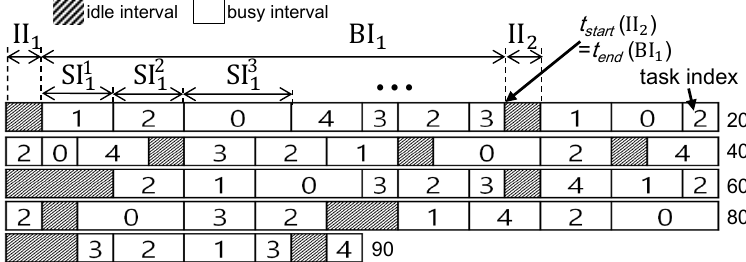
Figure 1. An example of the monitoring interval during 90 time units; for example, the first line indicates the execution information for the first 20 time units, and time slots with gray color and white color mean no execution and execution with the corresponding task,